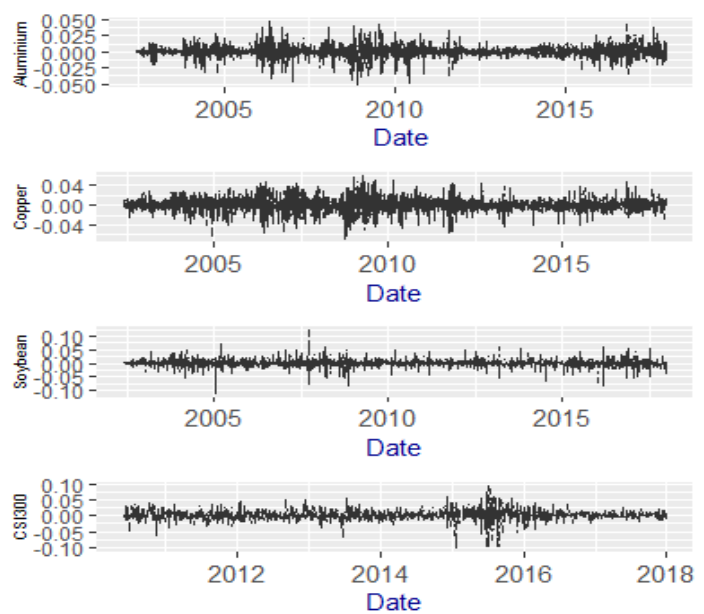
Figure 1. The price of the futures contract.